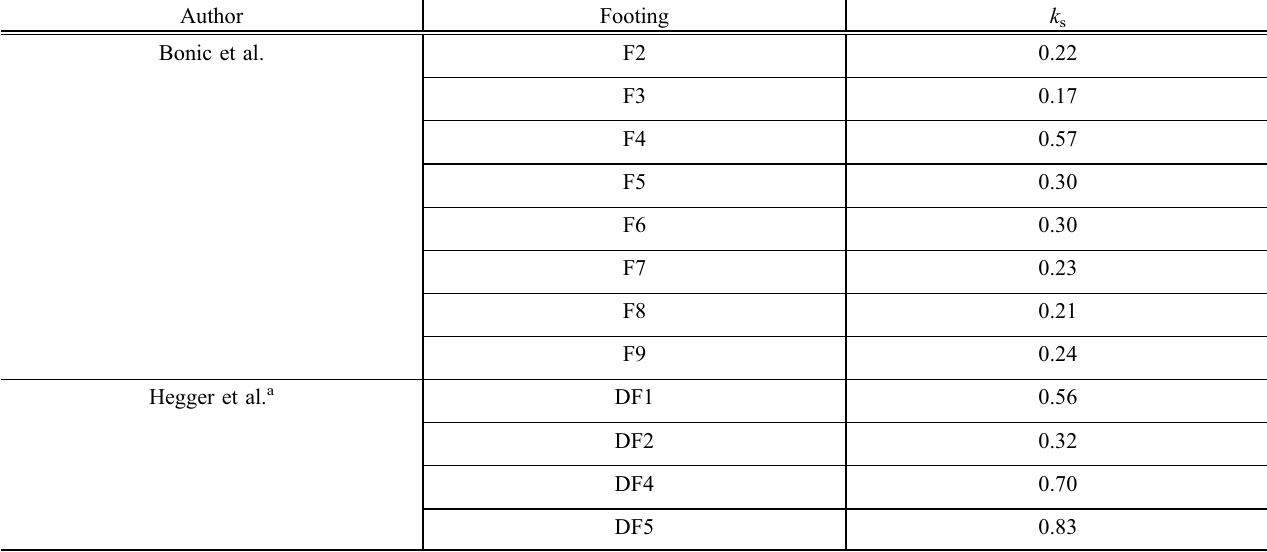
Table 5 Values of k s for the examined footings.